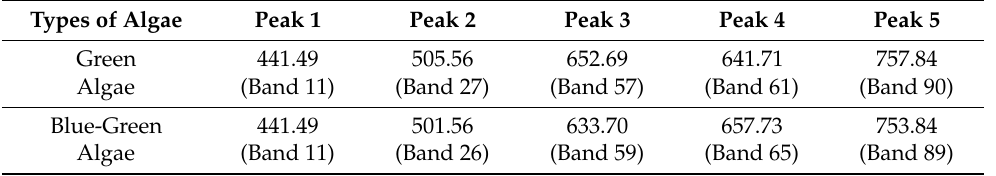
Table 5. Selected spectrum peak values of